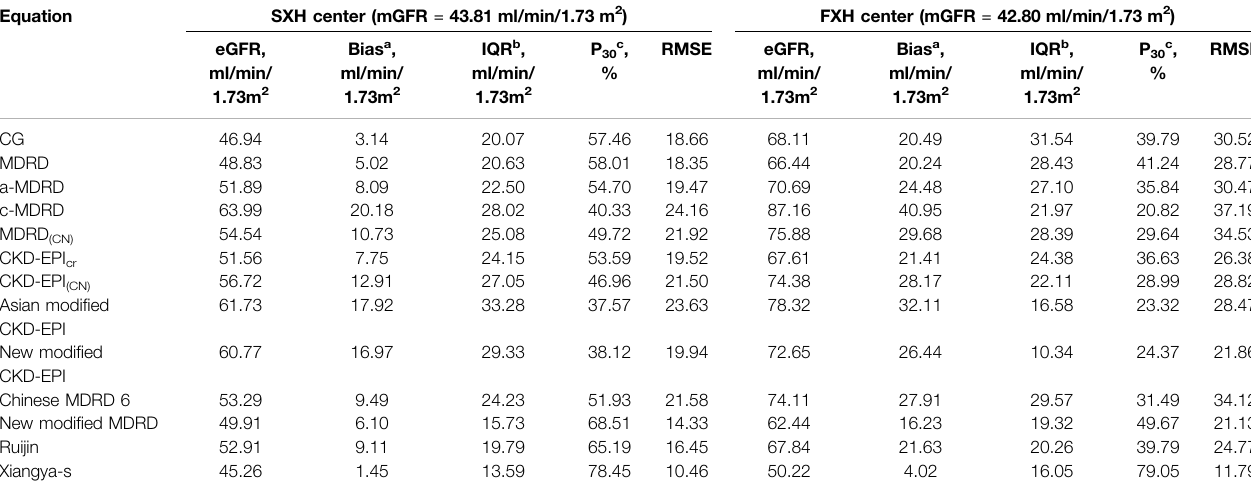
TABLE 3 | Performance of eGFR equations in the inpatients of external validation sample.